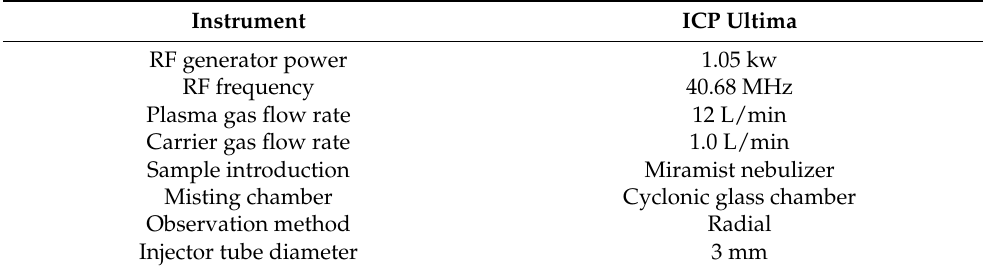
Table 7. Analytical conditions for ICP-AES.